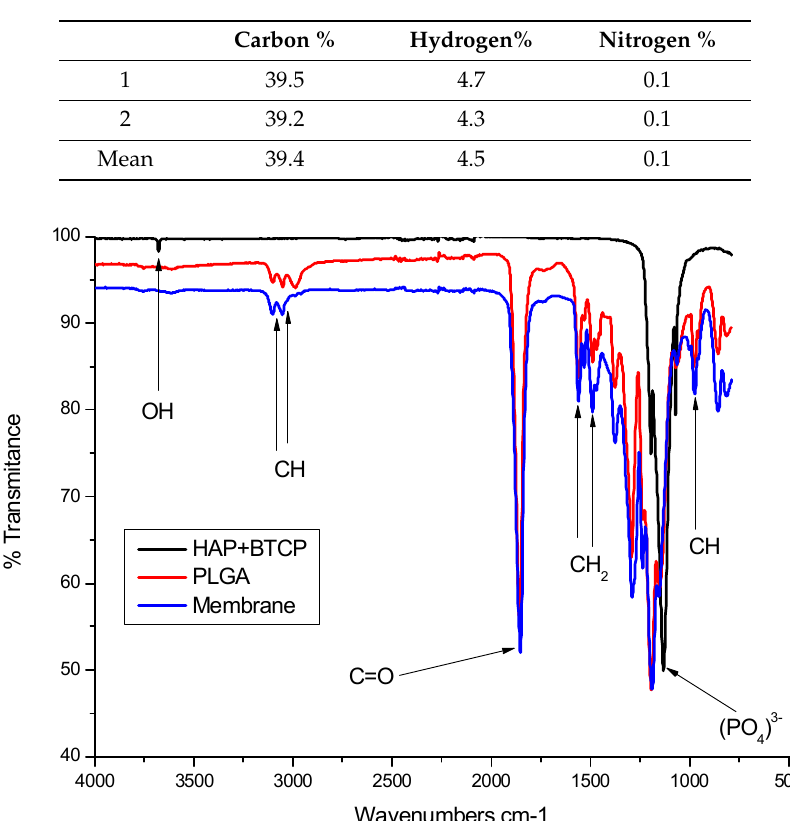
Table 1. CHN SO PE 2400 series II, PerkinElmer.